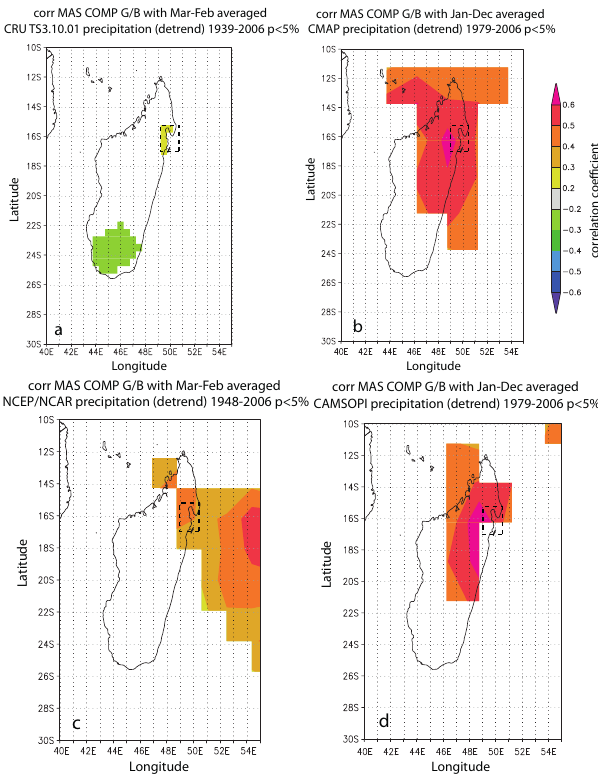
Fig. A2. Spatial correlations of the annual mean MAS G/B compos- ite record with rainfall data from (a) CRU TS3.10.01 (Mitchell and Jones, 2005), (b) CMAP (Xie and Arkin, 1997), (c) NCEP/NCAR reanalysis (Kalnay et al., 1996) and (d) CAMS OPI (Janowiak and Xie, 1999). The mean annual average for the optimal correlation with the G/B record has been chosen for individual rainfall datasets. The G/B composite record was composed of MAS1, MAS3, MASB and ANDRA for the common time period of 1930–2006. Only cor- relations > 95% significance level are shown in colour. See legend for correlation coefficients. Study area indicated by rectangular box (stipled). Correlations computed at